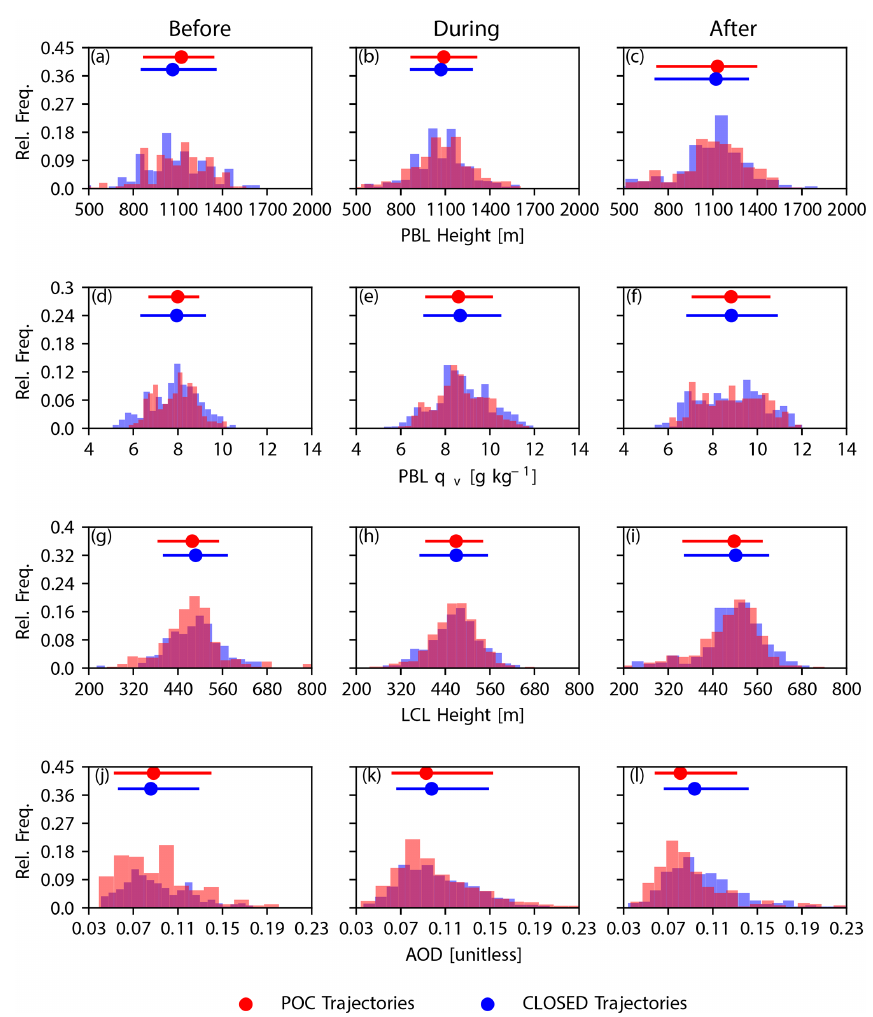
Figure 16. Distributions of environmental properties before a POC forms (left column), during POC lifetime (middle column), and after POC dissipation (right column). The top row (a, b, c) shows planetary boundary layer (PBL) height. PBL-average water vapor mixing ratio q v is shown in the second row (d, e, f) . Lifted-condensation level height is shown in the third row (g, h, i) . Aerosol optical depth is shown in the fourth row (j, k, l) . Red represents distributions mapped to the POC trajectories, while blue represents the distributions mapped to the CLOSED trajectories. The colored dots represent the median of each distribution, and the horizontal lines represent the spread between the 10th and 90th